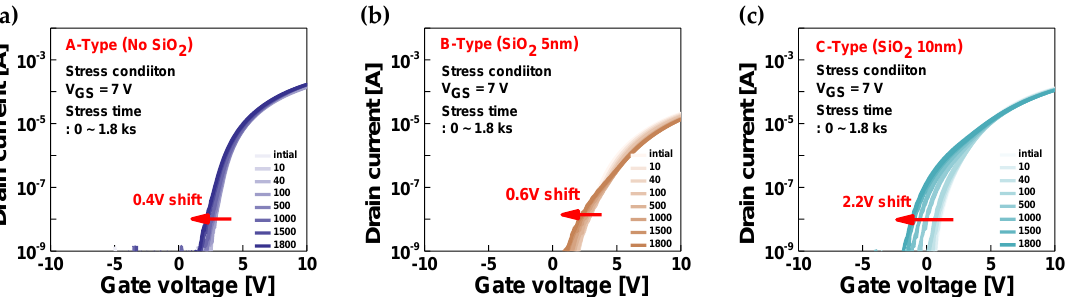
Figure 2. I-V characteristics of ( a ) A-type, ( b ) B-type, and ( c ) C-type IGZO TFTs under a positive bias stress (PBS). When the thickness of the SiO 2 layer is sufficiently wide, a significant threshold voltage shift occurs in the PBS condition.